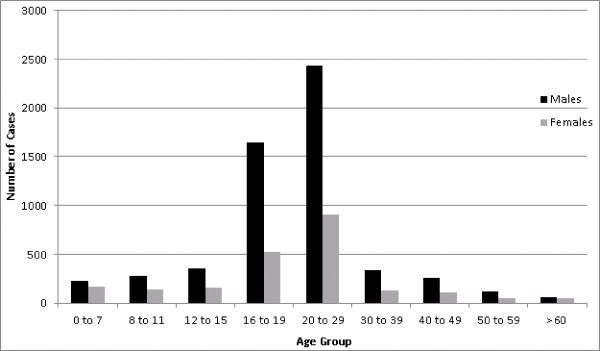
Age distribution of human brucellosis cases in men illustrated by the black bars and women displayed by the grey bars.